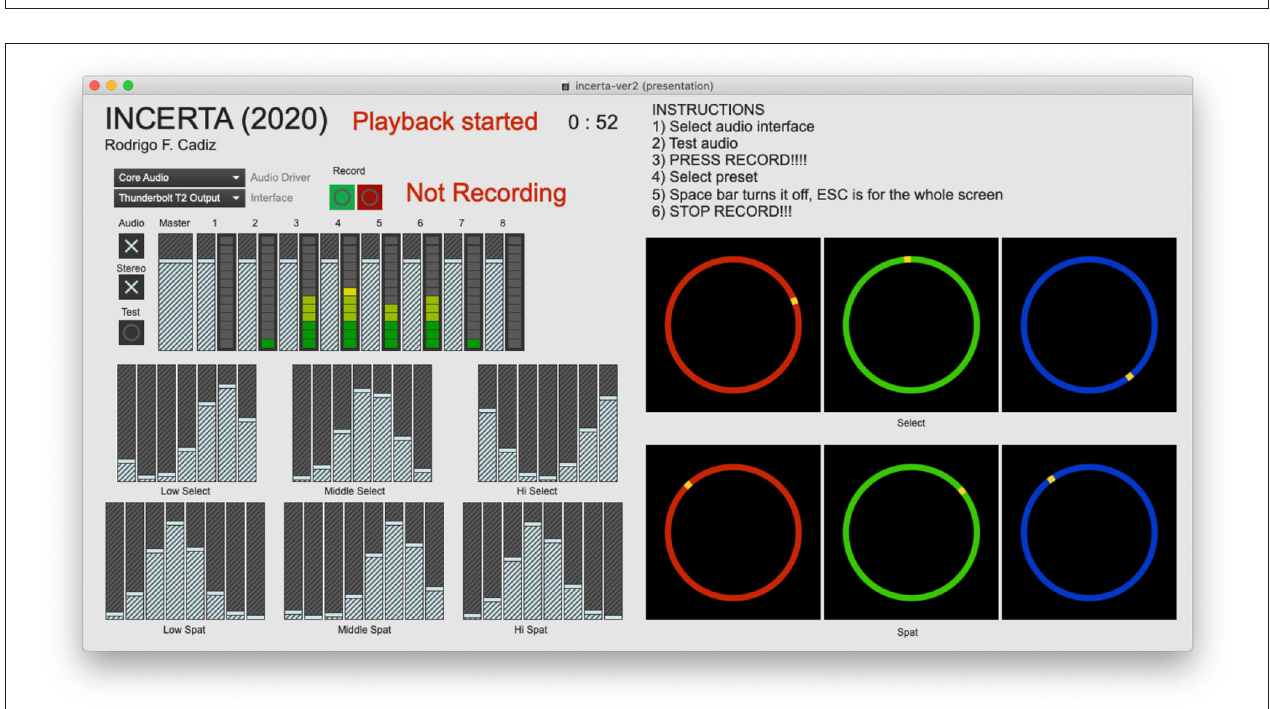
FIGURE 9 | Screenshot of the main interface of Incerta at time 0:52. The six Gaussian curves for the control of the sound material selection and spatialization can be seen at the bottom left. Circles on the right displays the rotation angle that is used to specify the mean value of each Gaussian curve.